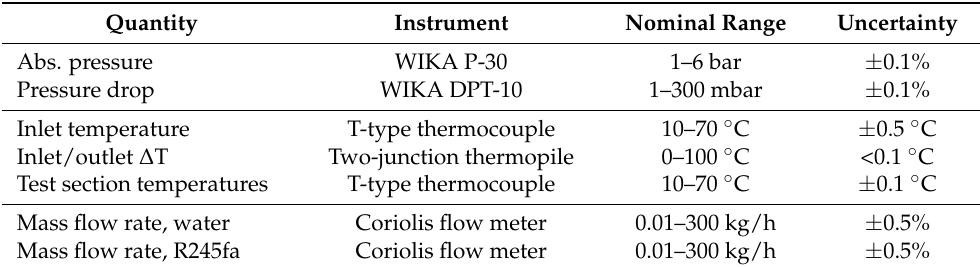
Table 1. Measurement equipment and its nominal